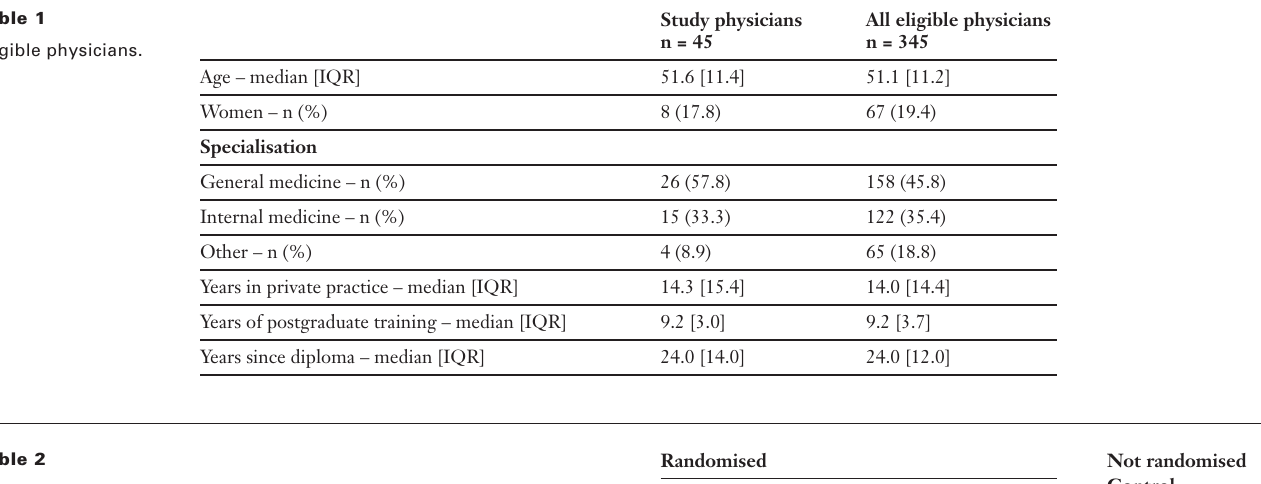
Study physicians.